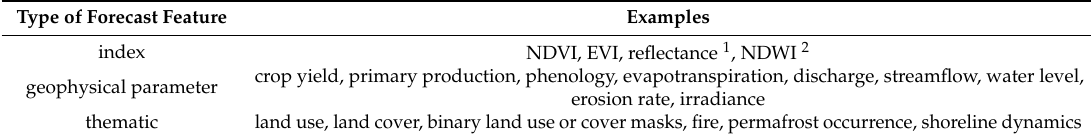
Table 3. Examples of forecast variables for each feature type.